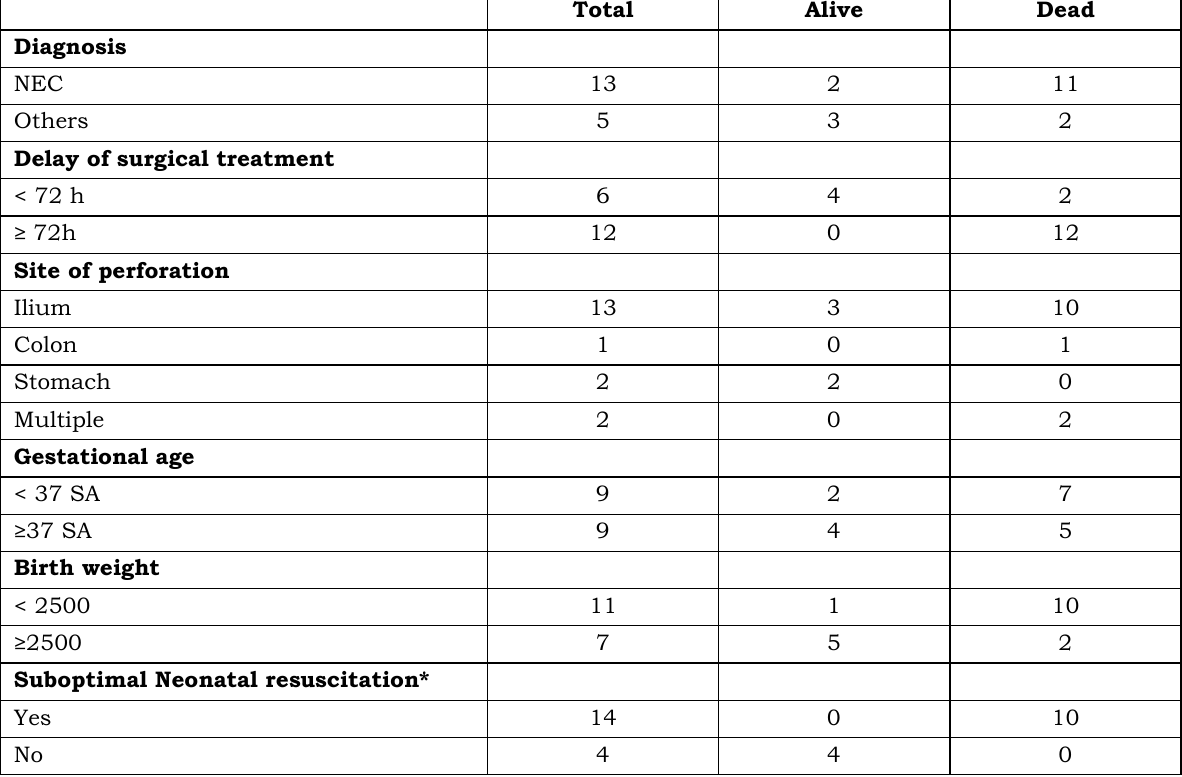
Table 1: Factors influencing the outcome of neonates with